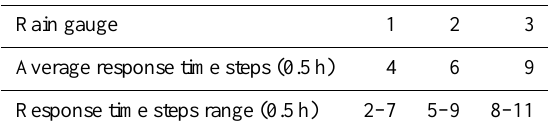
Table 2. Values of statistically estimated response times (based on cross-correlations), and indications on the range of sliding window lengths investigated using cross-validation (1 stands for Mialet, 2 for Saint-Roman-de-Tousque, and 3 for Barre-des-C´evennes). Rain gauge 1 2 3 Average response time steps (0.5h) Response time steps range (0.5h)